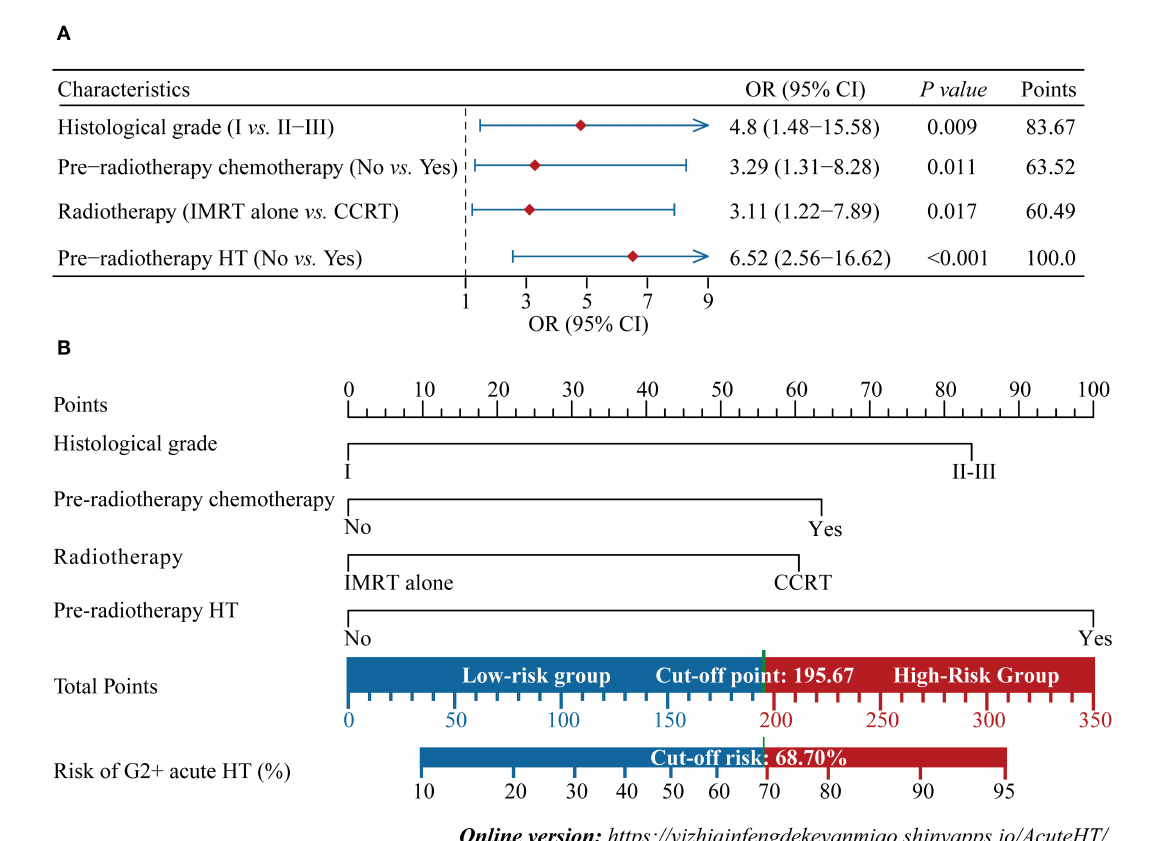
FIGURE3 Development of the nomogram. Multivariate logistic regression forest plot for four independent predictors (A) , and the nomogram developed based on these predictors (B) . IMRT, intensity modulated radiation therapy; CCRT: concurrent chemoradiotherapy; HT, hematological toxicity; OR, odds ratio; CI, confidence interval. G2 + , Grade ≥